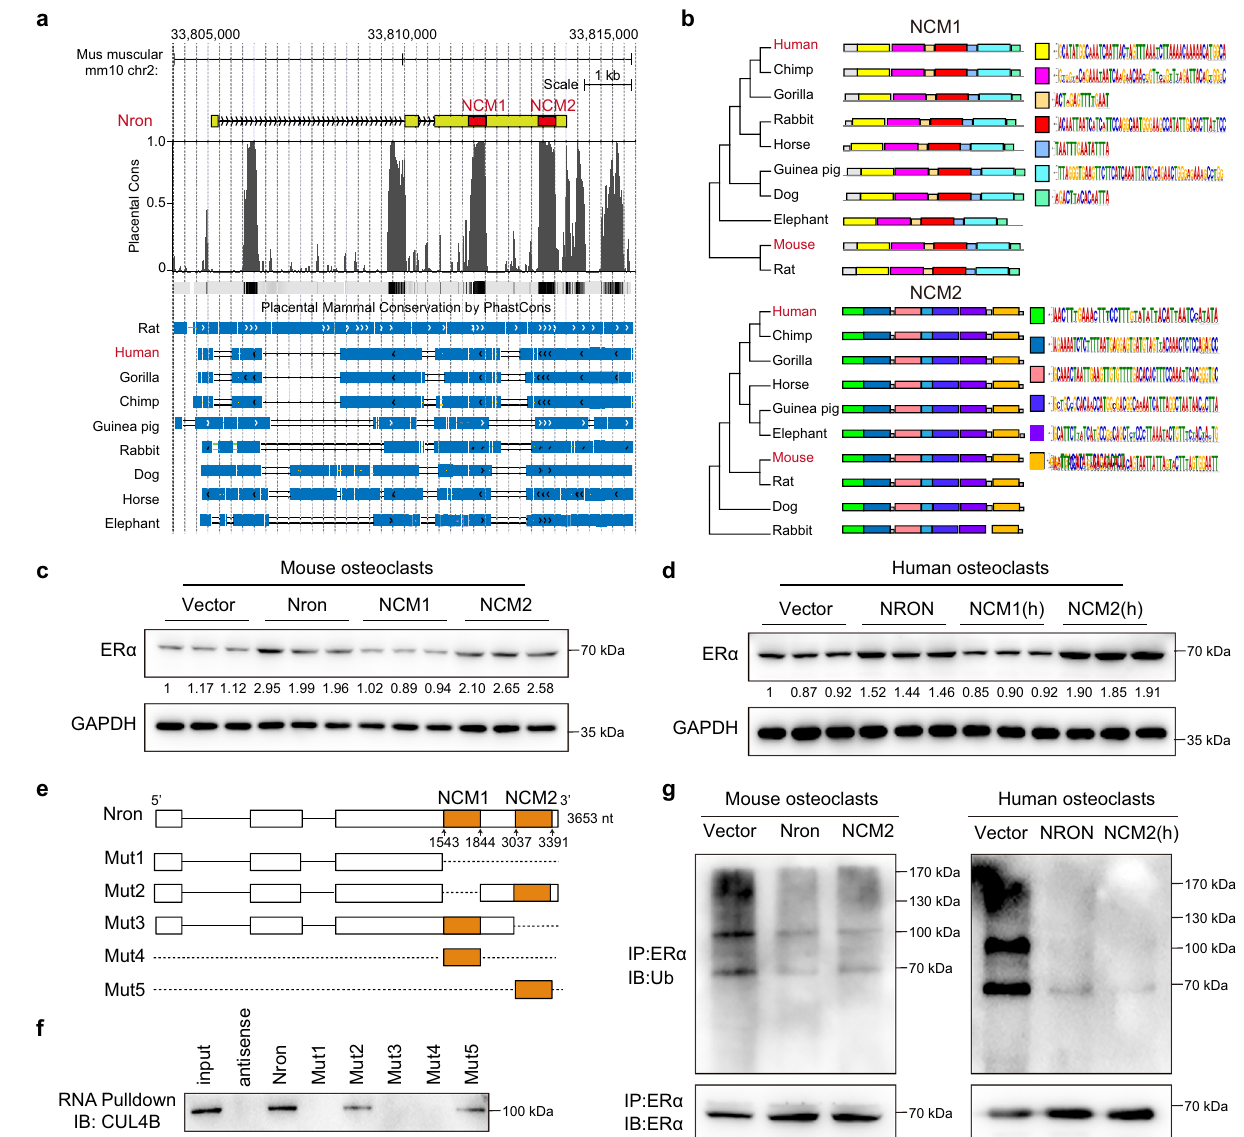
Fig. 6 Functional motif of Nron interacts with Cul4b to regulate ER α ubiquitination. a Genome browser depiction of Nron and its conserved analogs in multiple species. b Evolutional tree of NCM1 and NCM2 in multiple species. c Expression of ER α in osteoclasts with Nron, NCM1, or NCM2 overexpression analyzed by WB. The experiment was repeated three times independently with similar results. d Expression of ER α in human THP-1 derived osteoclast with NRON, NCM1(h), NCM2(h) overexpression were analyzed by WB. The experiment was repeated three times independently with similar results. e Schematic diagram illustrating the mutation strategies of Nron. f Interactions of Nron and Nron mutants with CUL4B determined by RNA pull-down assay in mouse osteoclast lysates. The experiment was repeated three times independently with similar results. g The ubiquitination of ER α in Nron or NCM2 overexpression osteoclasts were assessed by immunoprecipitation (IP) with anti-ER α antibody followed by ubiquitin WB analysis. The experiment was repeated three times independently with similar results. Source data are provided as a Source Data fi